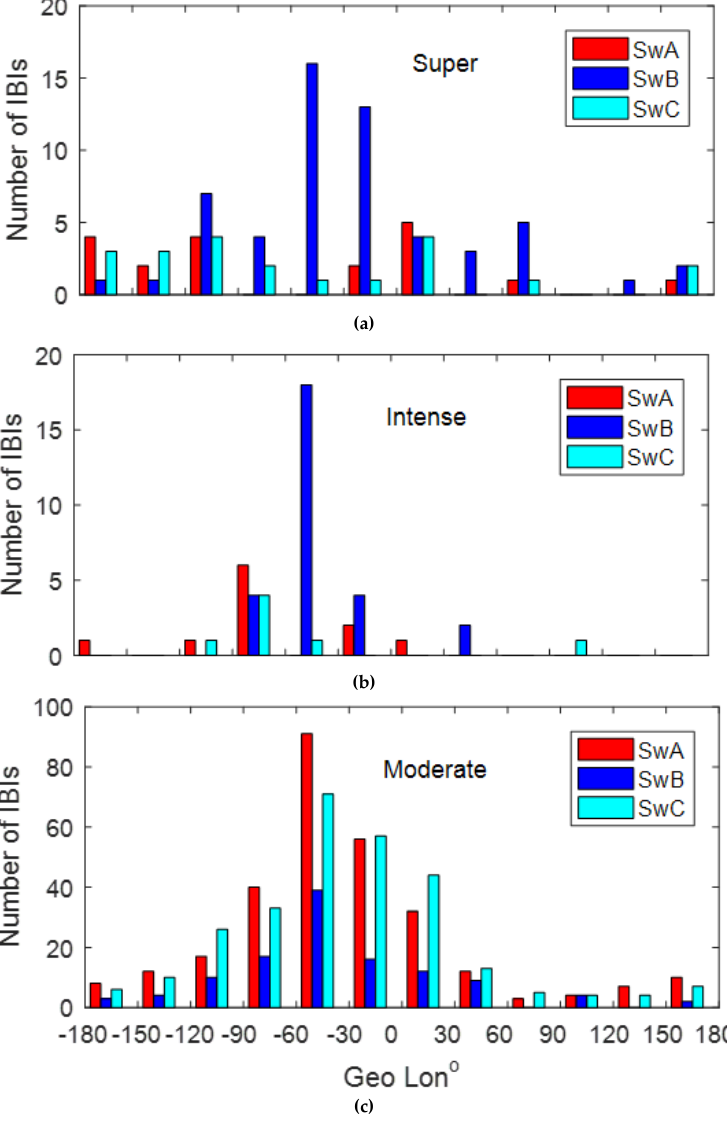
Figure 3. The occurrence number of IBIs with respect to geographic longitude observed during ( a ) super, ( b ) intense, and ( c ) moderate storms. The IBIs observed by Swarm A, B, and C are marked in red, blue, and cyan bars, respectively.